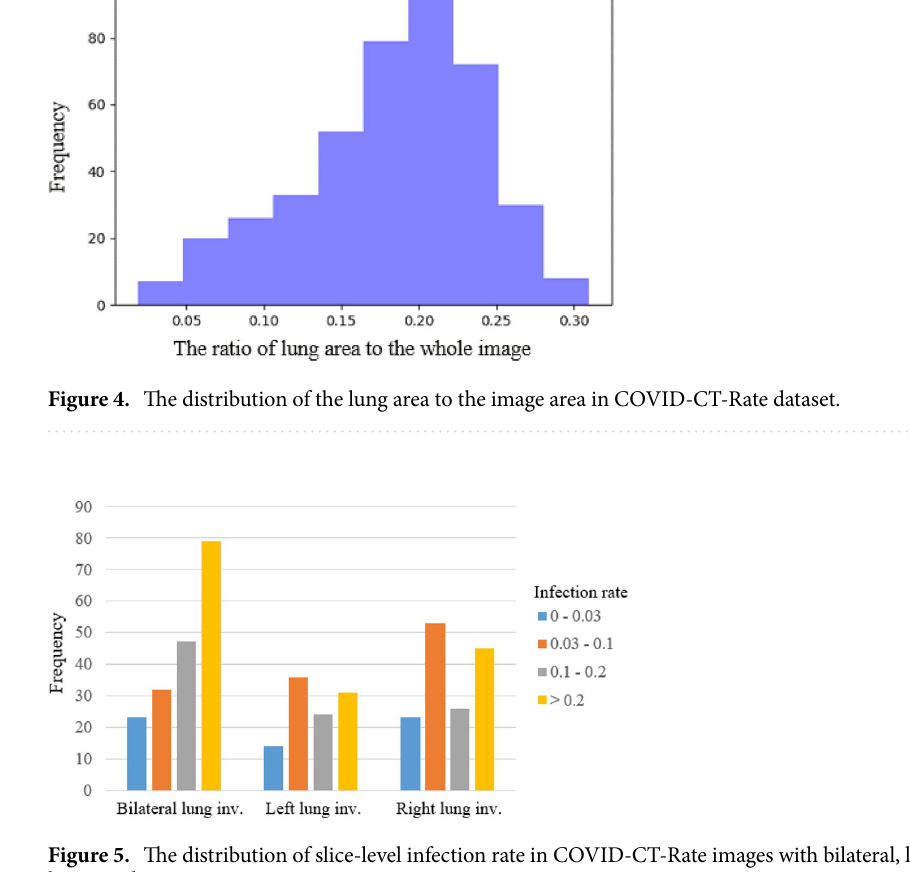
Figure 5. The distribution of slice-level infection rate in COVID-CT-Rate images with bilateral, left, and right lung